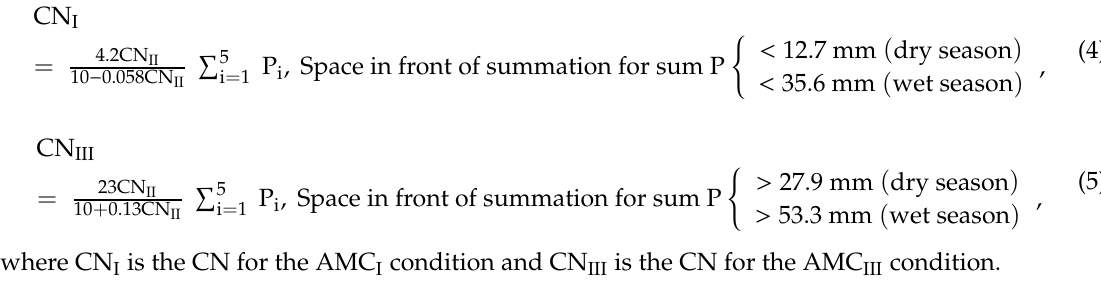
Table 2. Classification of antecedent soil moisture condition